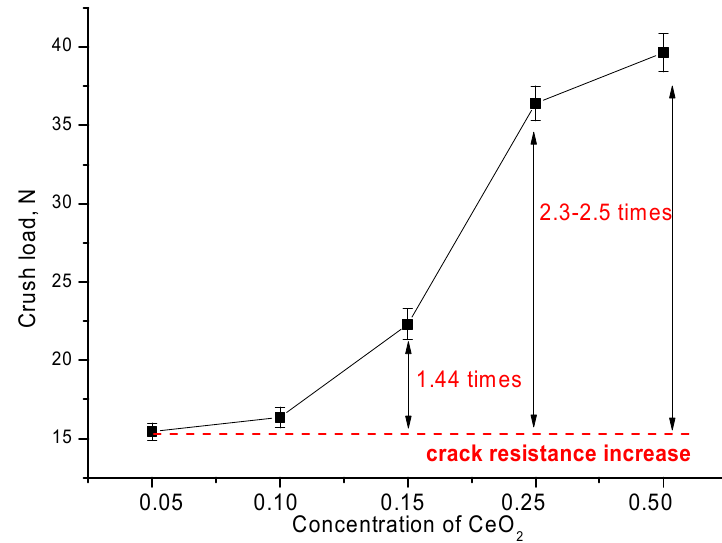
Figure 7. Graph of the change in crack resistance during a single compression.